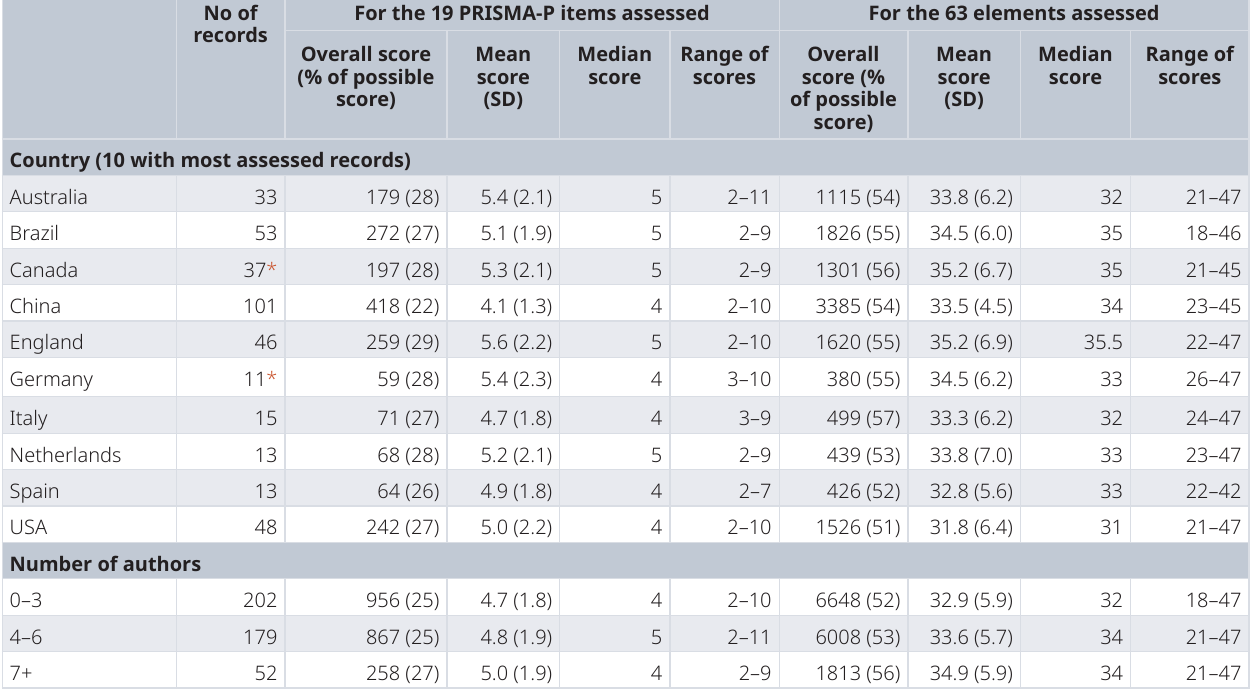
Table 4. Overall scores by country, number of authors and topic of review.